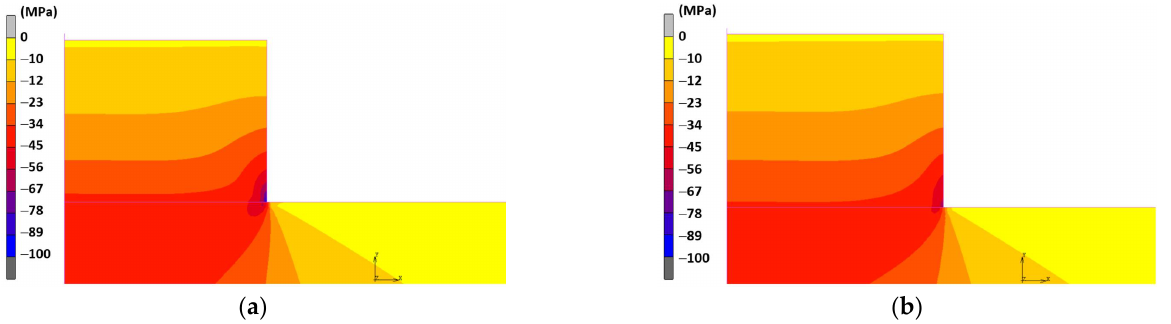
Figure 5. Distributions of the radial stress in: ( a ) a conventional shrink fit (without a contact ring) and ( b ), a modified shrink fit with a contact ring ( γ = 0.050).